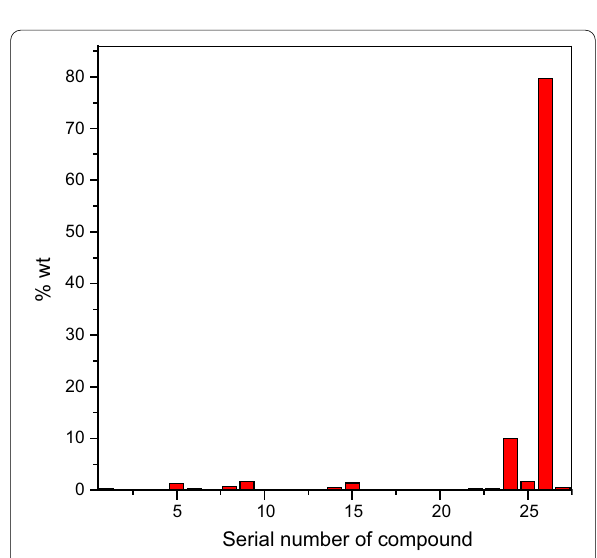
Fig. 3 Abundance of components in N. sativa